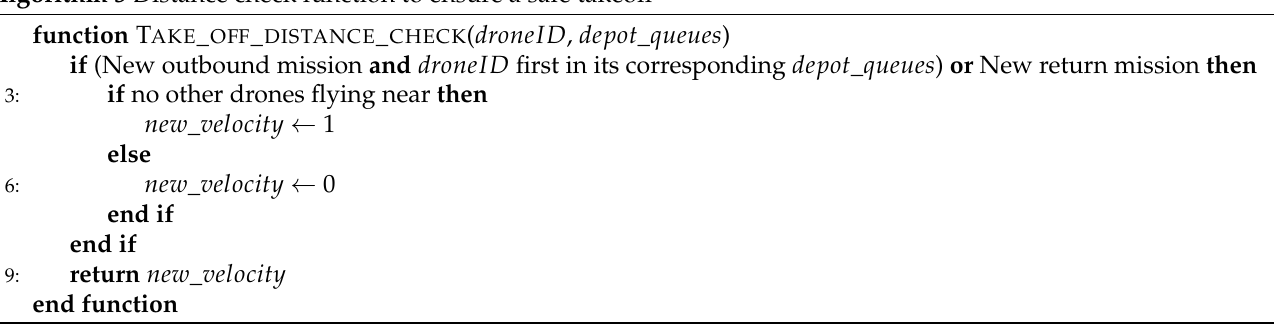
Algorithm 3 Distance check function to ensure a safe takeoff